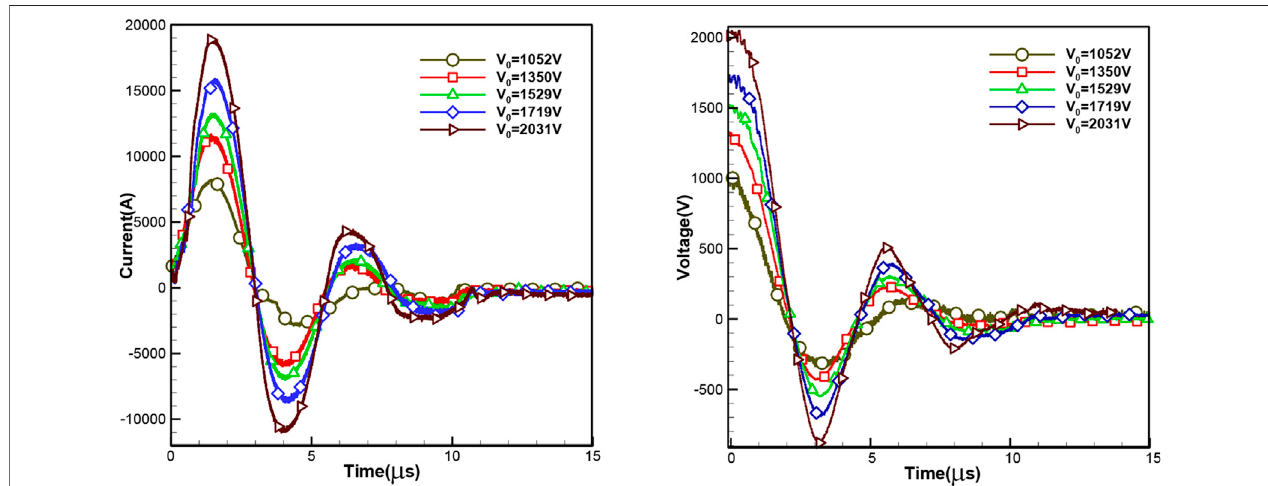
FIGURE 3 | APPT discharge waveforms at different initial voltages.